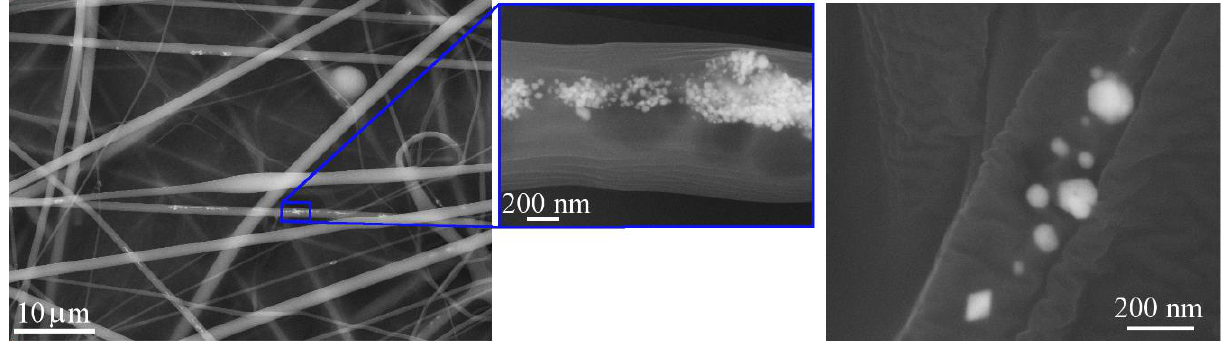
Figure 4. SEM images of ex situ PVA-5AgNPs fibers with detailed view of the AgNPs shape and distribution.